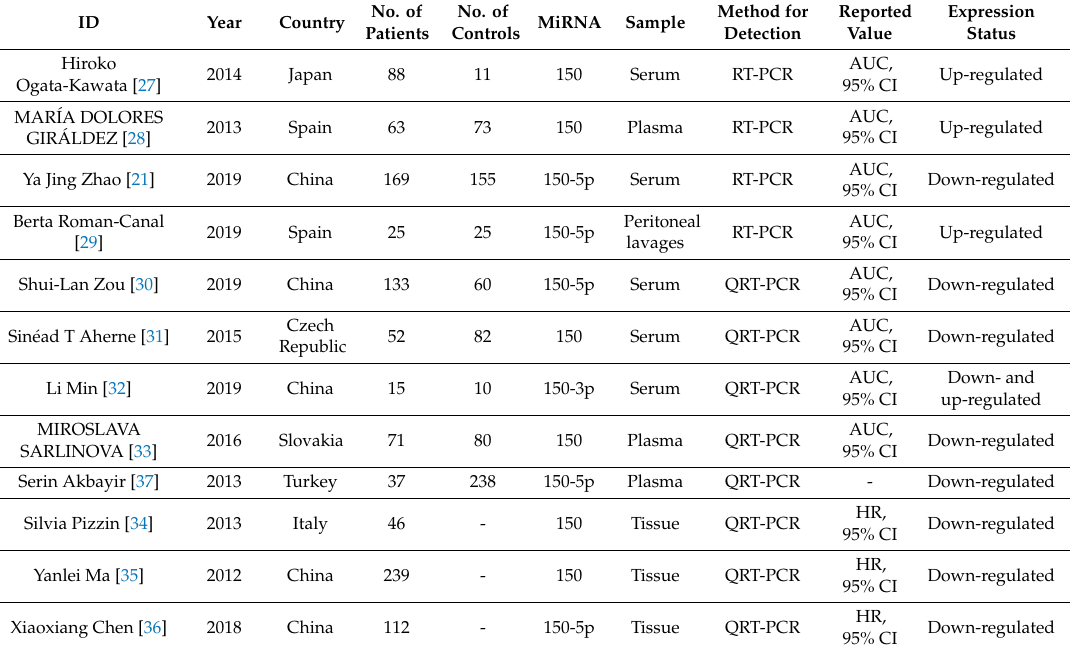
Table 1. Basic characteristics of the articles